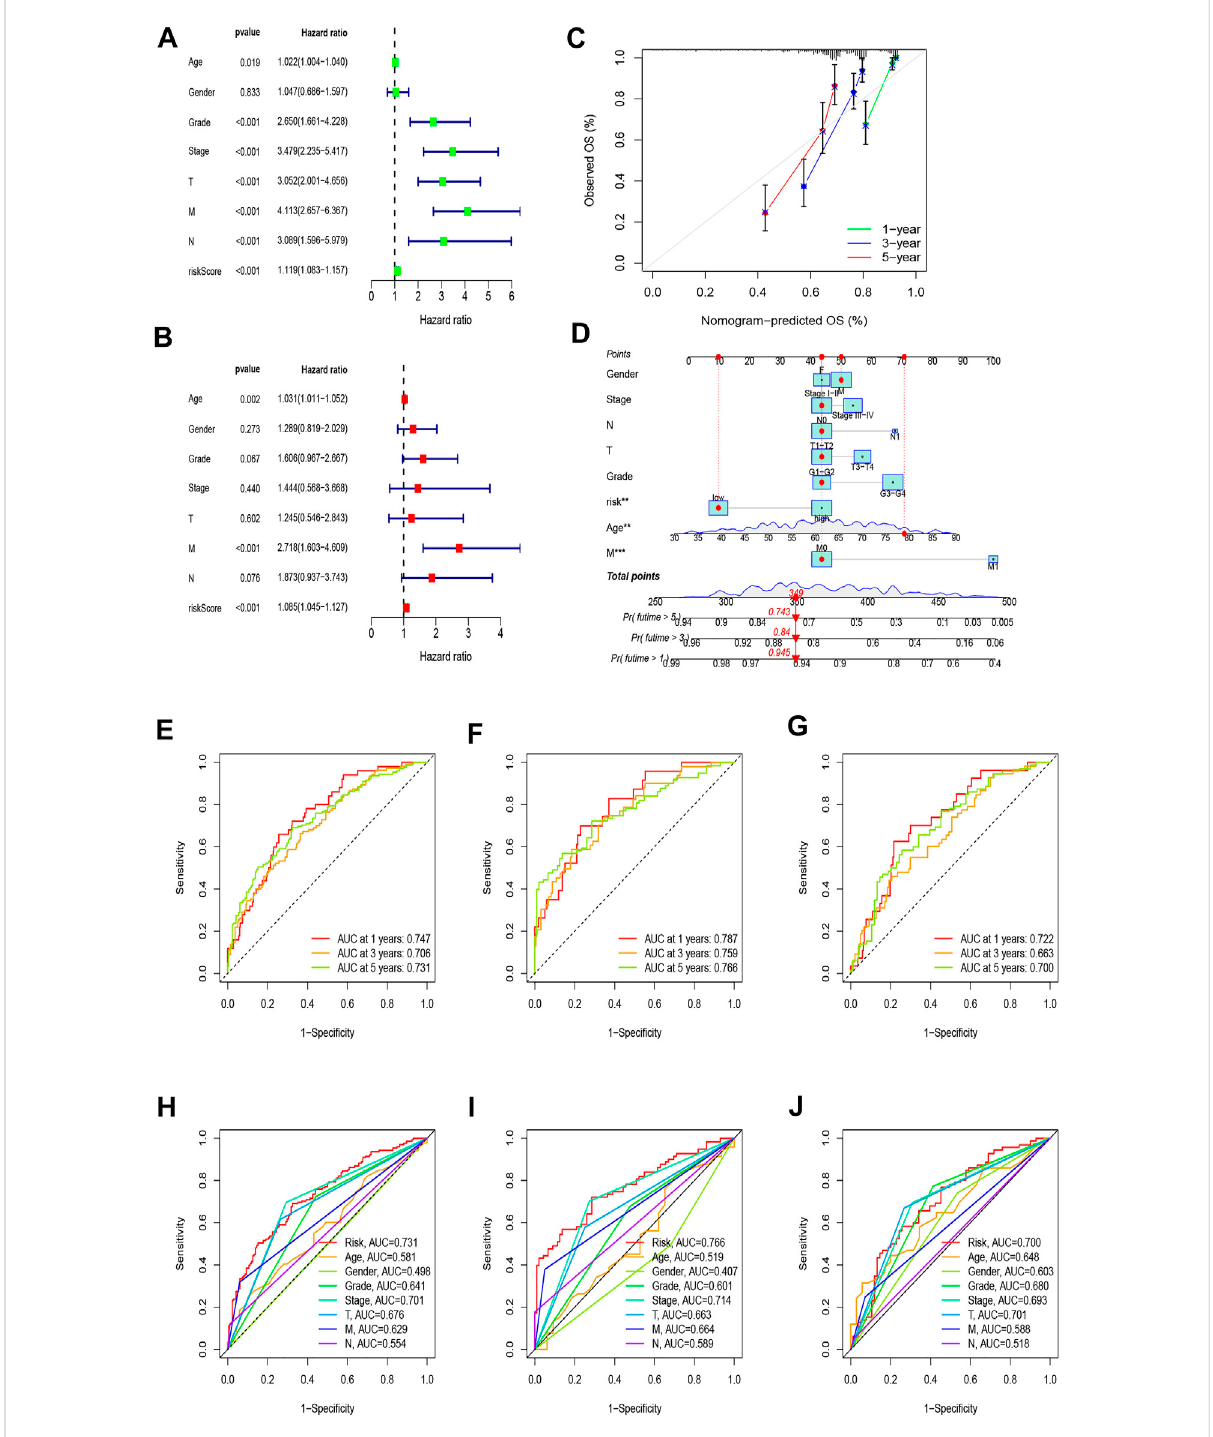
FIGURE 5 Nomogram and assessment of the risk model. (A,B) Uni-Cox and multi-Cox analyses of clinical factors and risk scores with OS. (C) Calibration curves for 1-, 3-, and 5-year OS. (D) The nomogram that integrated the risk score and clinical parameters to predict the 1-, 3-, and 5-year OS rate. (E – G) ROC curves for the 1-, 3-, and 5-year OS rate of the full, training, and test set, respectively. (H – J) ROC curves for 5-year OS rate of risk score and clinical parameters of the full, training, and test sets,